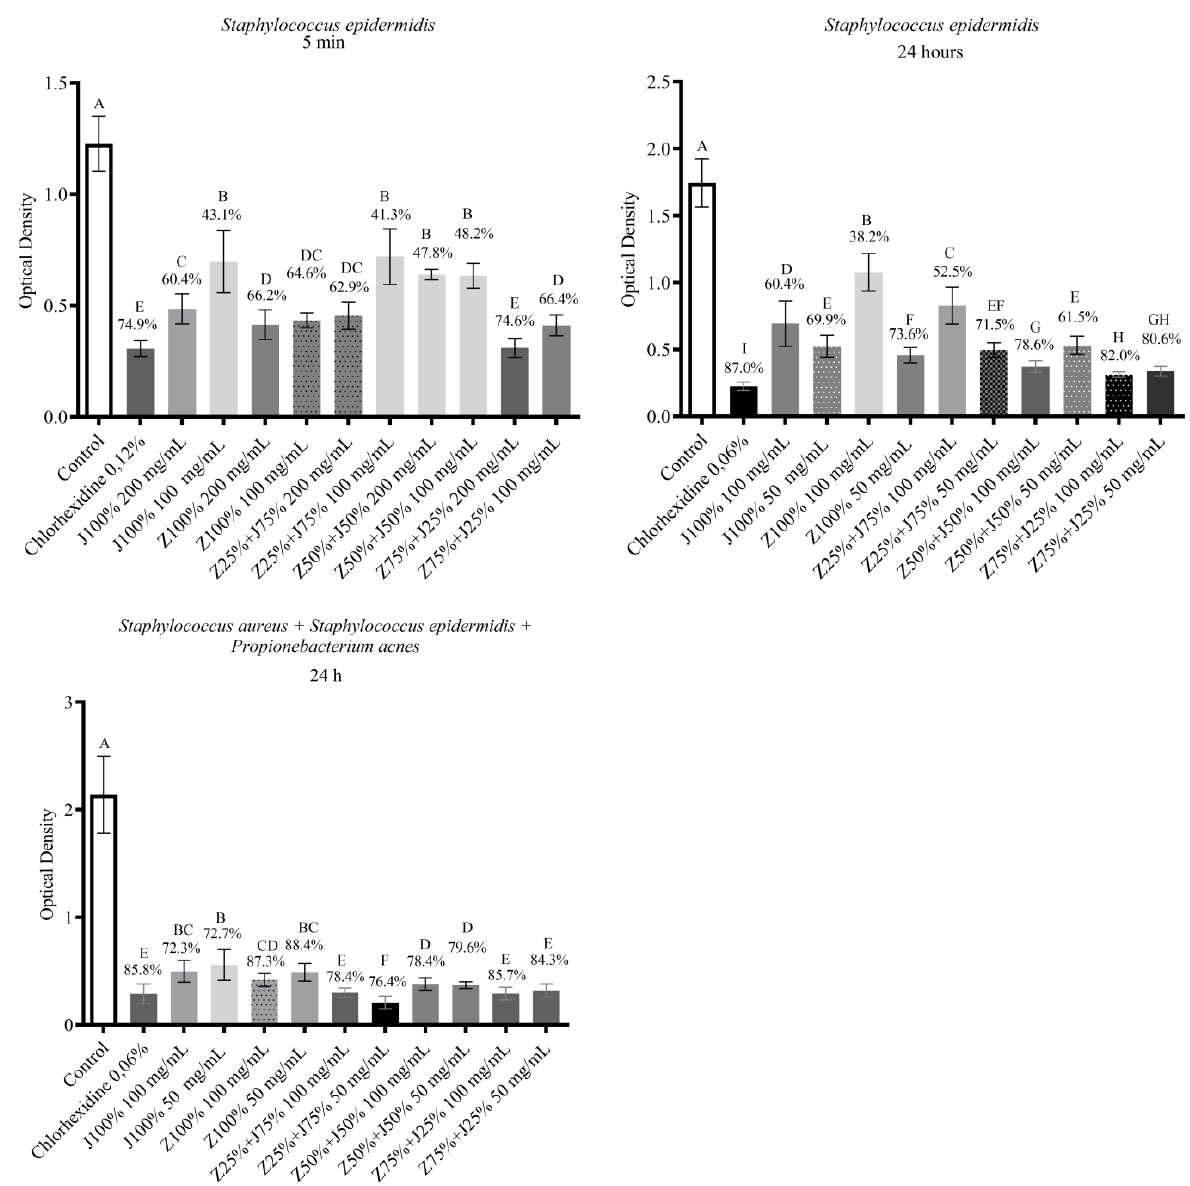
Figure 2. Antibiofilm action of association by Z. officinale and J. regia extracts on monotypic biofilm of S. epidermidis and heterotypic